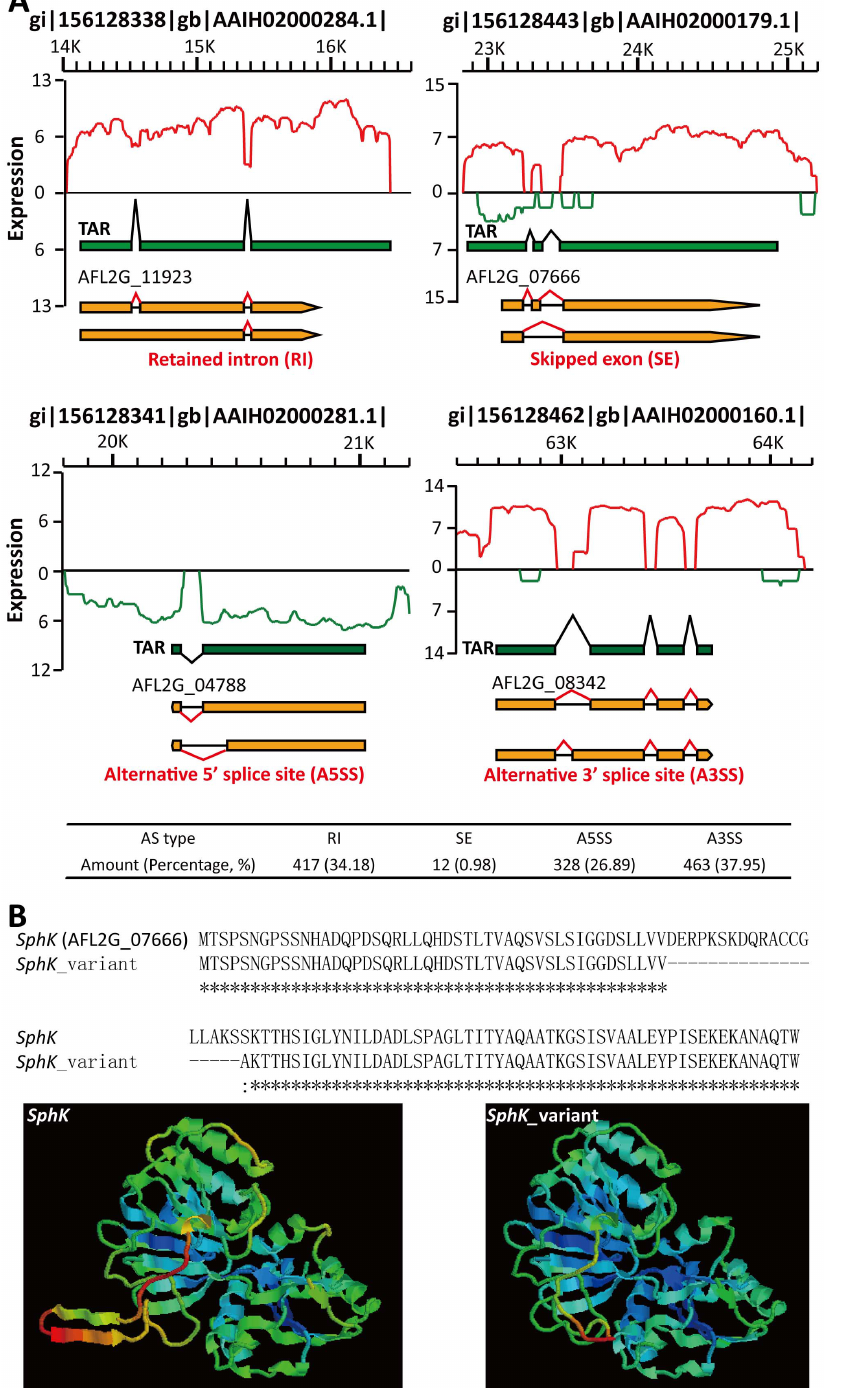
Figure 4. Illustration of AS events (RI, SE, A5SS and A3SS) identified in the A.flavus transcriptome. (A) Green bar, the transcriptional active region (TAR). Orange bar, A. flavus annotated genes. Knuckle lines (black or red), the relation with TARs or exons. The types and amounts of AS events are shown. (B) Amino acid alignment and homologous 3D modeling of AFL2G_07666 ( SphK ) and its AS variant ( SphK _variant). Broken line, the skipped exon of SphK . doi:10.1371/journal.pone.0097814.g004 There are more NATs located inside coding regions (768, the post-transcriptional level, which is consistent with the 39.14%) compared to UTR regions (466, 23.76%, Fig. 5A ). This conclusion reported by Donaldson et al [28]. The inside-biased means NATs in A. flavus might regulate gene expression mainly at NAT distribution in A. flavus , however, was different from the 3 9 -